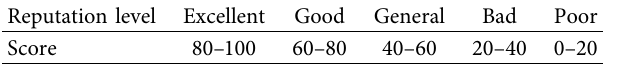
Table 5: The reputation levels and